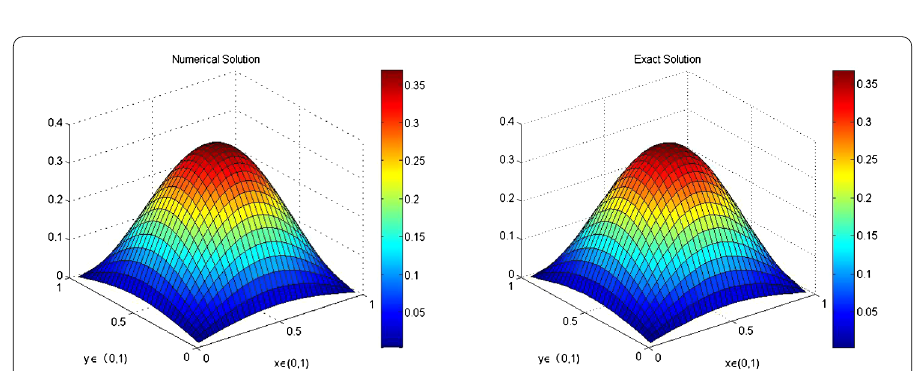
Figure 5 The effect of numerical solution and exact solution at fixed T = 1, h = 1 ( a ) N = 2 5 . ( b ) N = 2